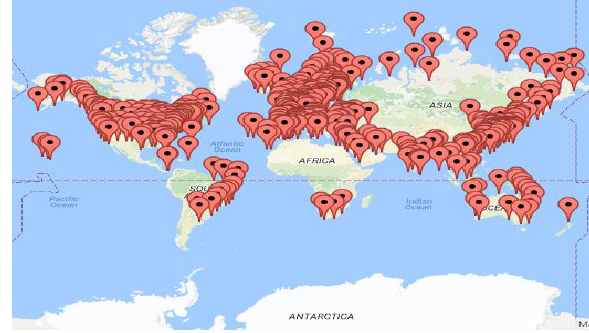
Figure 2. DGPS station